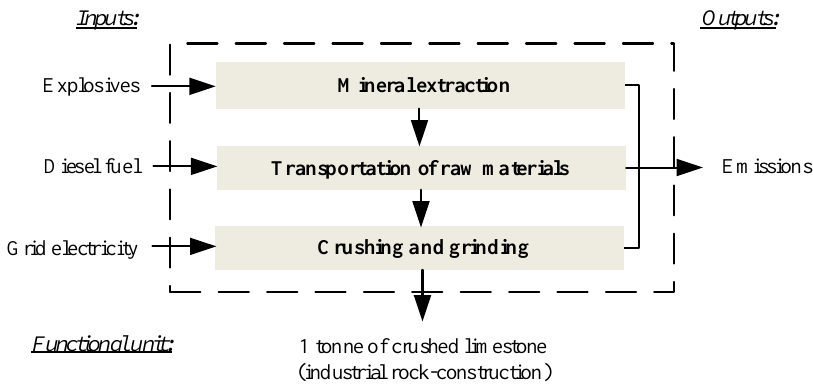
Fig. 4. Flow diagram and system boundaries of limestone quarrying operations of the Plant